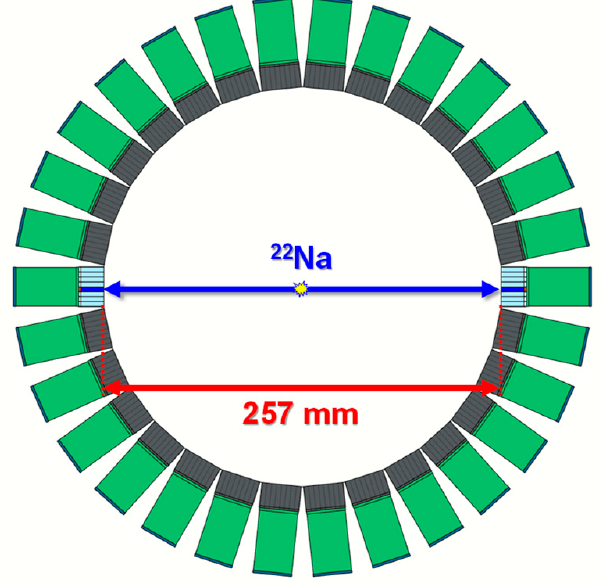
Figure 7. Experimental setup to evaluate the performance (energy resolution, CCR, and CTR) of the detector module. The 22 Na point source was placed at the center between a pair of channels. The energy resolution was measured by calculating the full width at half maximum (FWHM) using a Gaussian fit to the photopeak position corresponding to 511 keV in the energy spectrum acquired with energy values of the list-mode data. The CCR was measured by calculating the total number of prompt coincidence data detected during the data acquisition time. The CTR was measured by calculating the FWHM using a Gaussian fit to the coincidence peak position in the time spectrum acquired with the difference in time values of the prompt coincidence data. To optimize the performance of the detector module, the energy resolution, CCR, and CTR were measured (repeated three times) while changing the overvoltage (V OVER ) of the MPPC and T1 of the ASIC. The V OVER and T1 values were set at 1 V increments from 1 to 7 V and five increments from 20 to 60, respectively. The optimal V OVER and T1 values were determined considering average values of the energy resolution, CCR, and